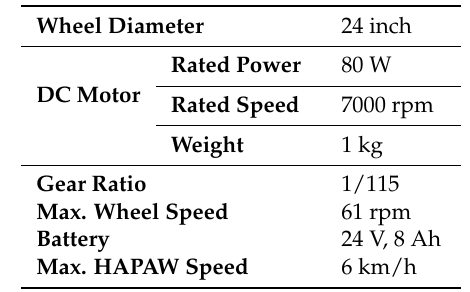
Table 1. The specifications of the developed HAPAW.